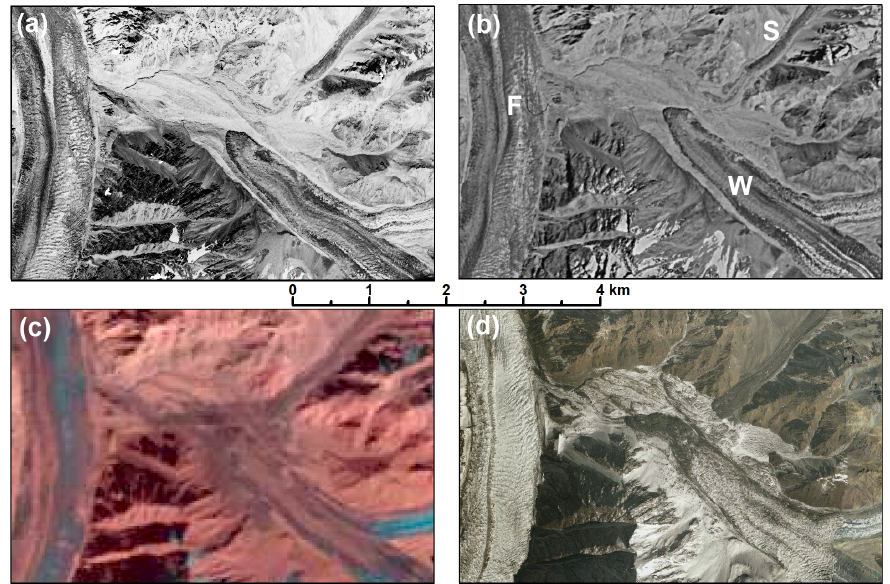
Figure 2. Comparison of satellite images for the same subregion (see Fig. 1 for location) showing the following glaciers: F – Fortambek (18), W – Walter 731 (19) and S – Soldatov (20). The images are acquired by (a) Corona in 1968, (b) Hexagon in 1975, (c) Landsat in 2017, and (d) Bing Maps (date unknown). Image sources: (a–c) earthexplorer.usgs.gov and (d) screenshot from http://bing.com (last access: 20